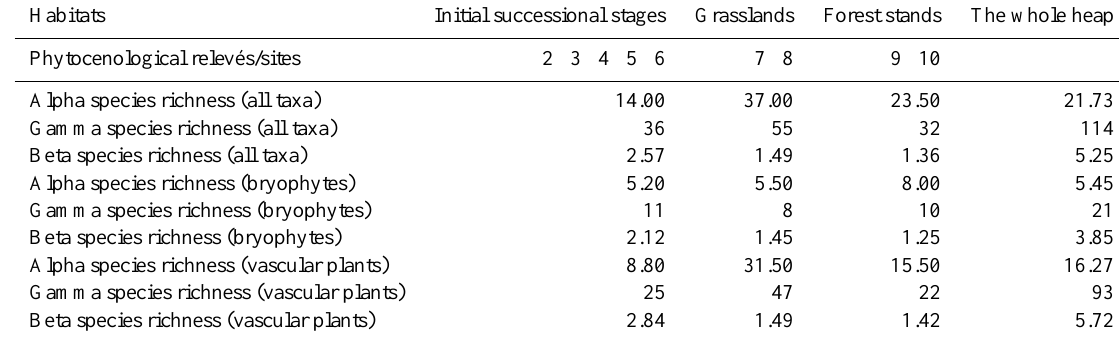
Table 1. Alpha, gamma and beta diversity on the order of species richness of the relevés classified according to successional stages. Habitats Initial successional stages Grasslands Forest stands The whole heap Phytocenological relevés/sites Alpha species richness (all taxa) Gamma species richness (all taxa) Beta species richness (all taxa) Alpha species richness (bryophytes) Gamma species richness (bryophytes) Alpha species richness (vascular plants) Gamma species richness (vascular plants) Beta species richness (vascular